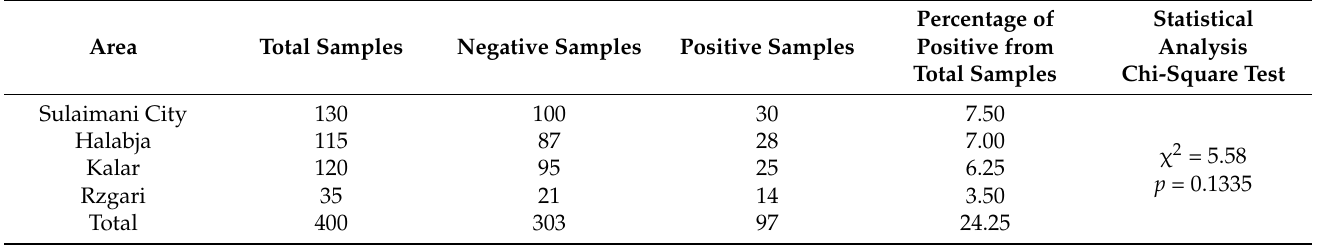
Table 1. The prevalence rate of Echinococcus granulosus among stray dogs in Sulaimani Governorate using microscopic examination of dog